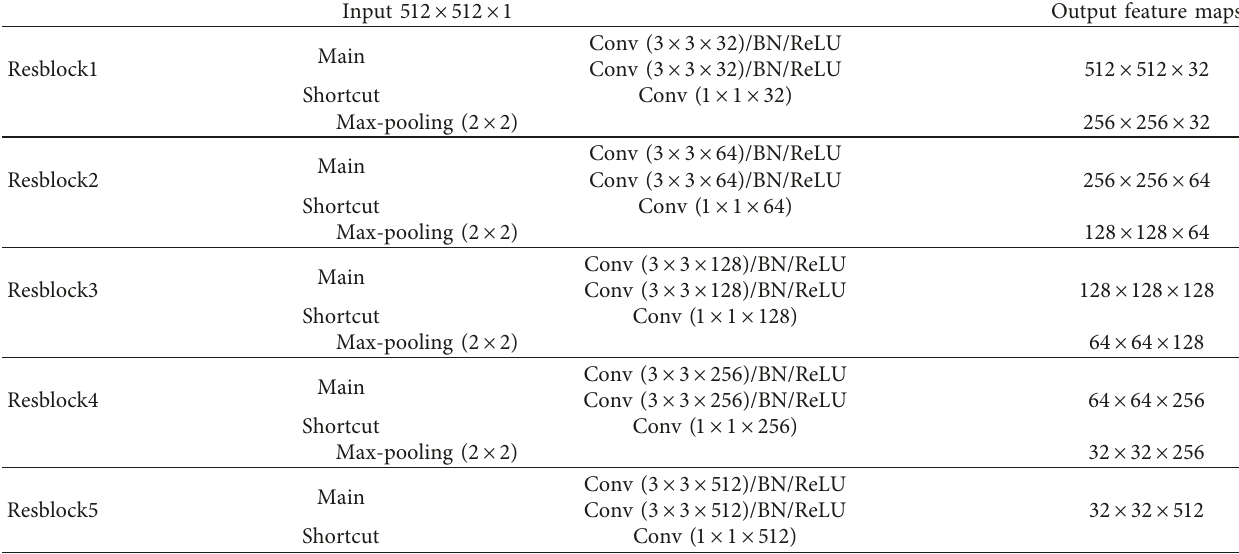
Table 1: The structure of the encoding module in our segmentation network.